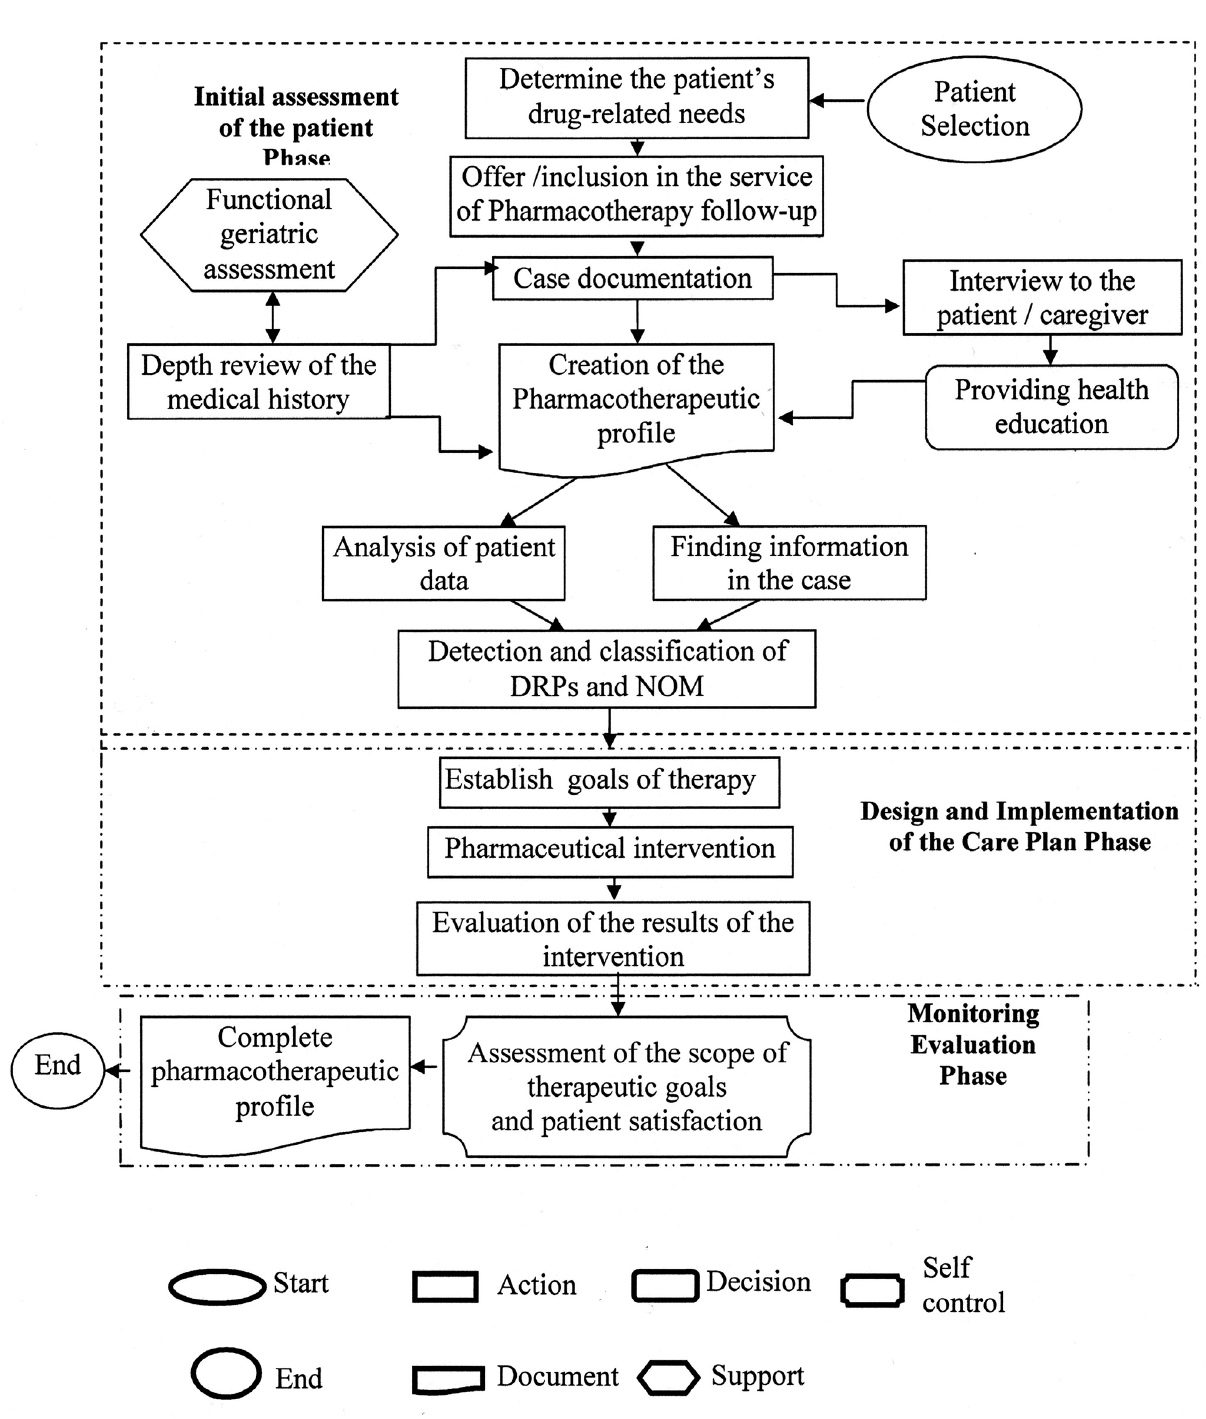
FIGURE 3 - Sequence of activities for the pharmacotherapy